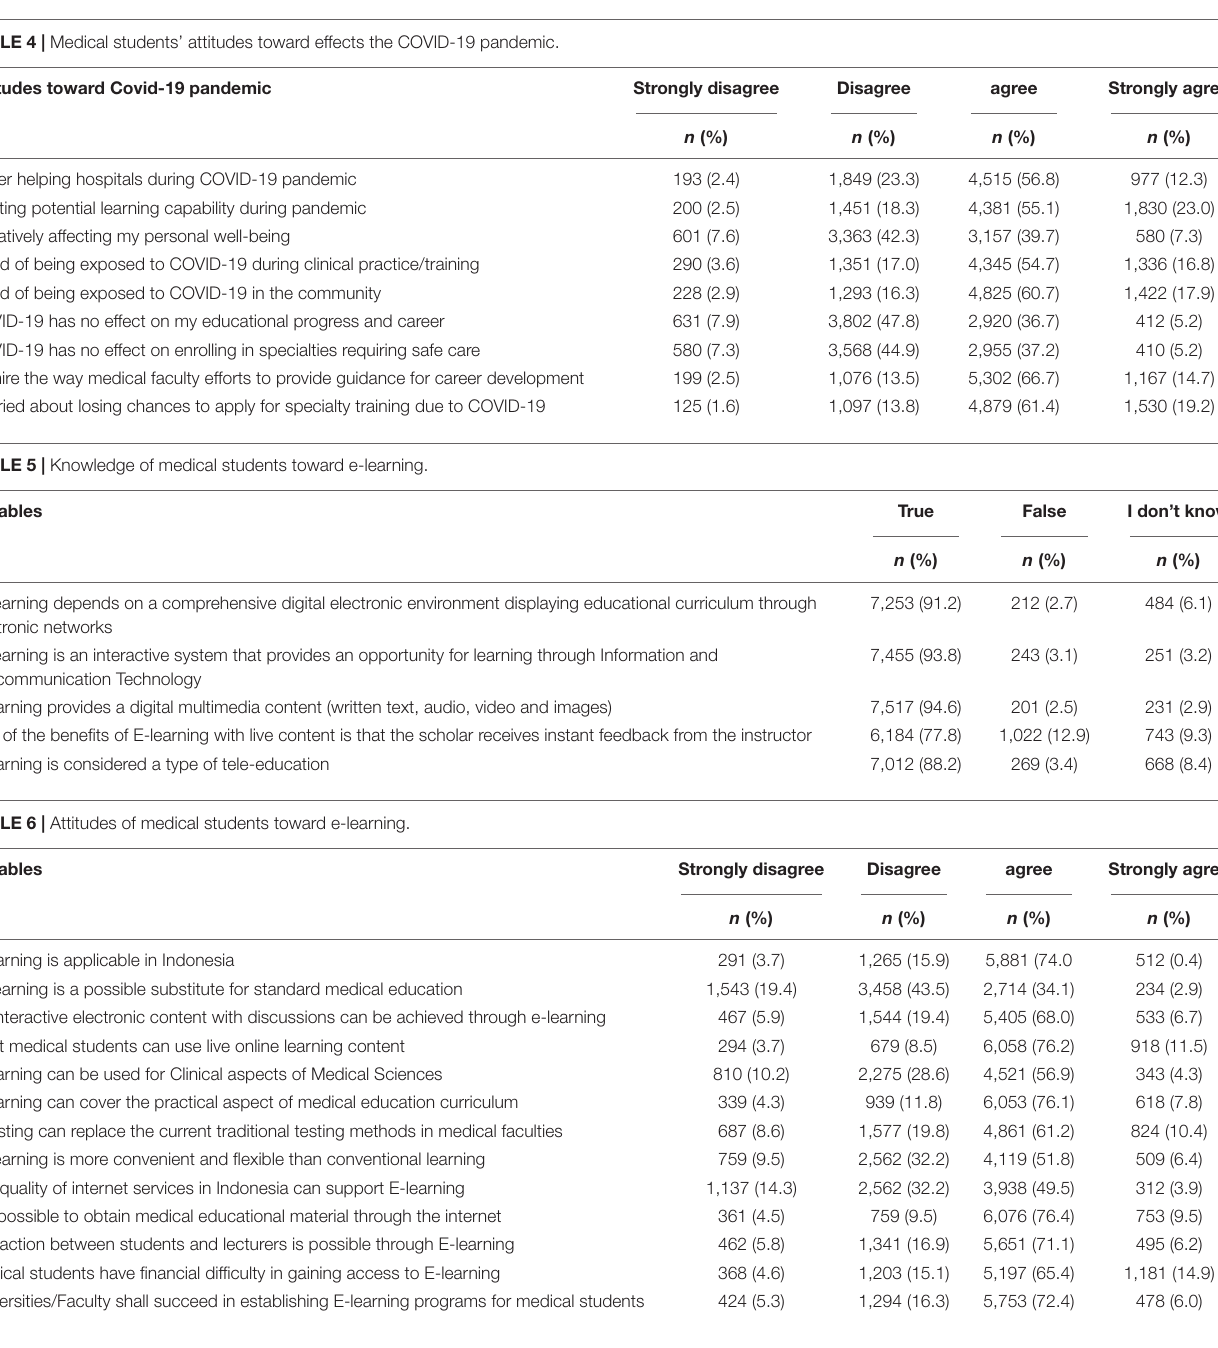
TABLE 4 | Medical students’ attitudes toward effects the COVID-19 pandemic.